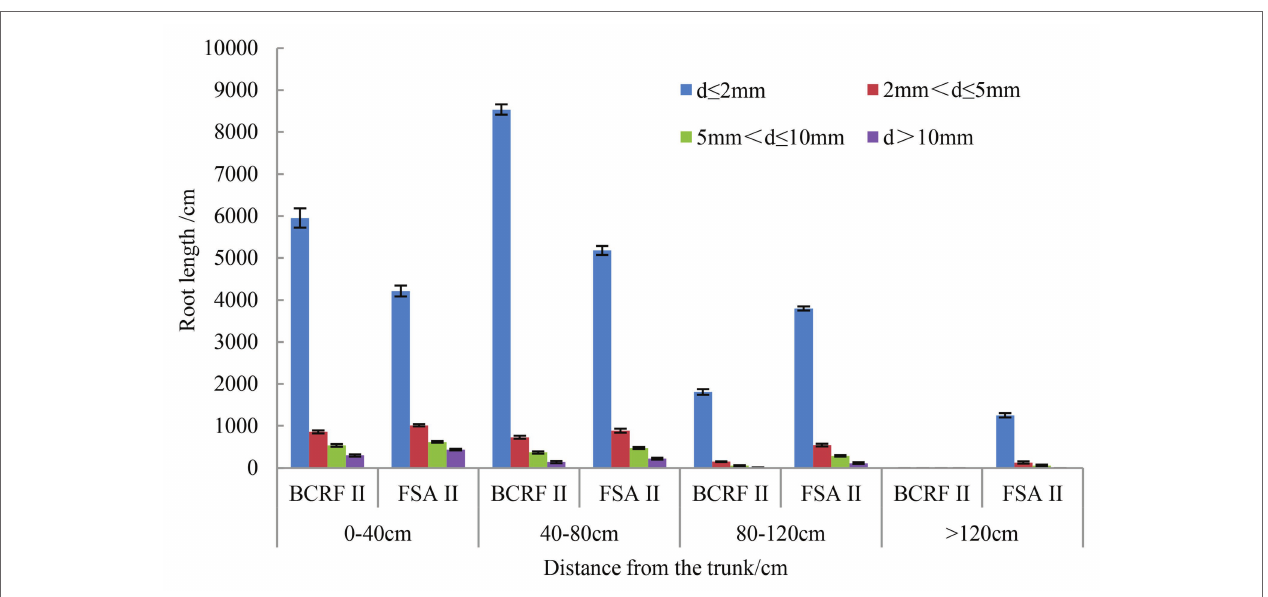
FIGURE 11 | Root horizontal distributions under different fertilization modes. The vertical bars indicate the standard deviation of three replications.